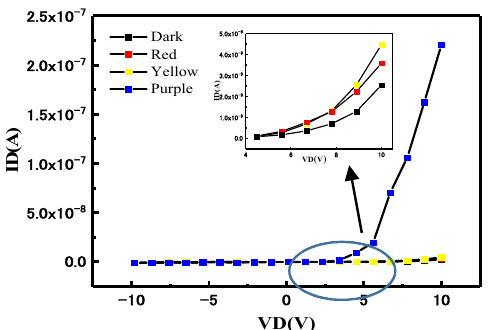
Figure 11. The I-V characteristics of the SnO 2 :15 at.% Si / SnO 2 :10 at.% Ga homojunction under excitation of different color lights and in the dark.